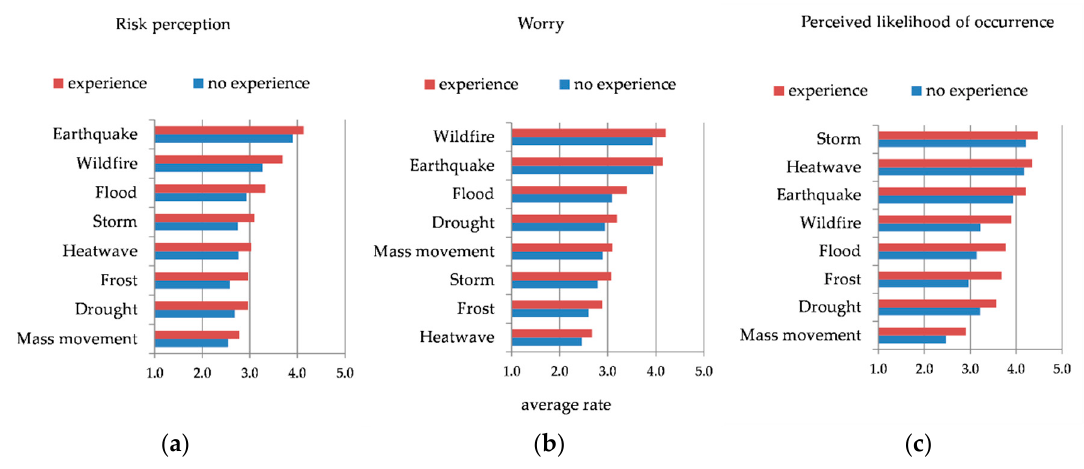
Figure 2. The effect of previous disaster experience on the average ratings assigned by the participants to the nine types of natural hazards survey, with regard to: ( a ) Risk perception in terms of importance, ( b ) feelings of worry they create, ( c ) perceived likelihood of occurrence.